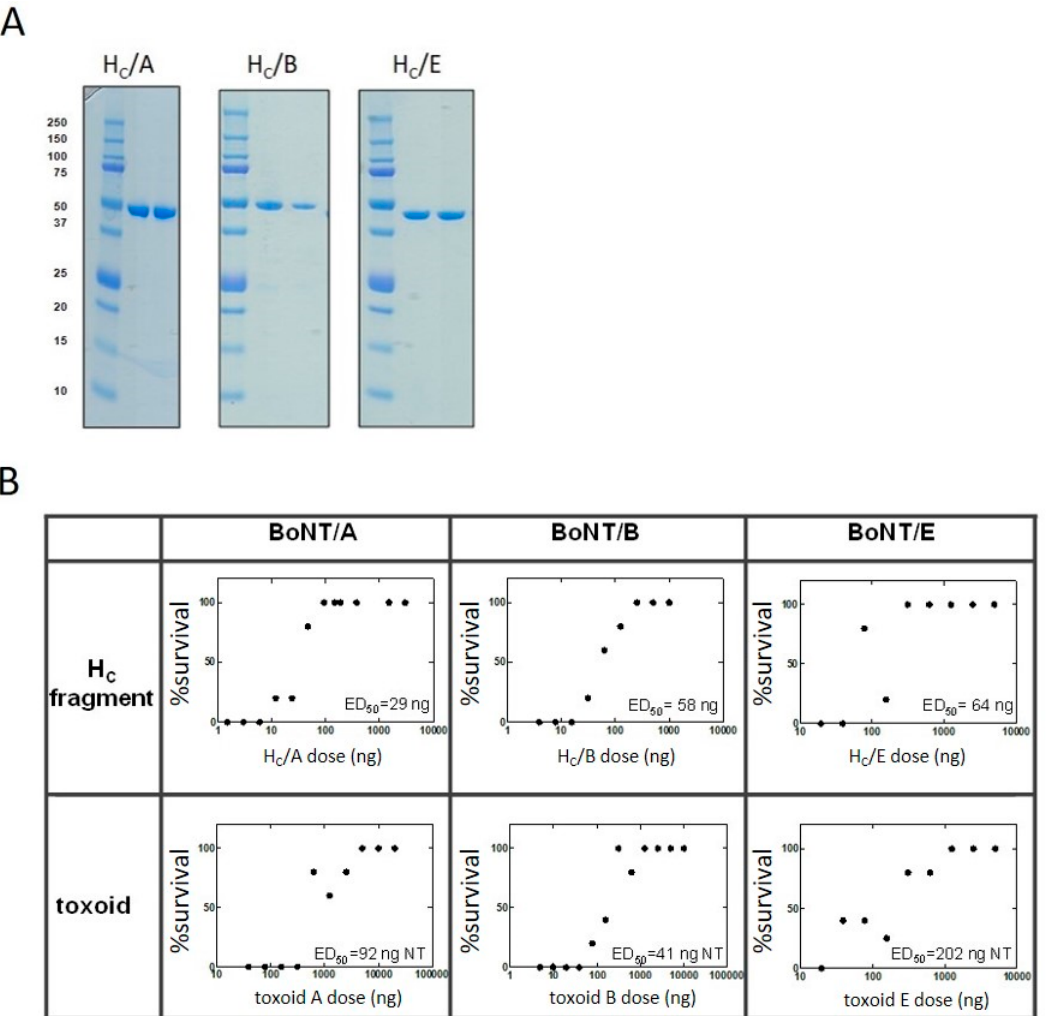
Figure 1. Comparative potency of recombinant BoNT subunits and botulinum toxoids in mice. ( A ) SDS-PAGE analysis of purified recombinant H C fragments. The indicated H C fragment serotype was separated in each corresponding gel under reducing (middle lane) or nonreducing (right lane) conditions. The left lane contains molecular weight marker with the indicated weight in kDa. ( B ) Nine groups of mice (5 per group) were vaccinated with serial doses (3.9–1000 ng) of either recombinant H C subunits (upper panels) or botulinum toxoids (lower panels). For serotypes A and B, mice were vaccinated once, and for serotype E, mice received three vaccinations at one-month intervals. Three weeks after immunization with serotype A or B antigens and 10 days after the last vaccination with serotype E antigens, all mice were challenged IP with 1000 Ms IP LD50 of the homologous serotype of botulinum toxin. Mice were monitored for survival for 10 days, and the cumulative results were analyzed by nonlinear regression to calculate the ED50, which is the antigen dose that conferred 50% protection in mice. ED50 values are indicated within each graph for every separate BoNT subunit or toxoid.